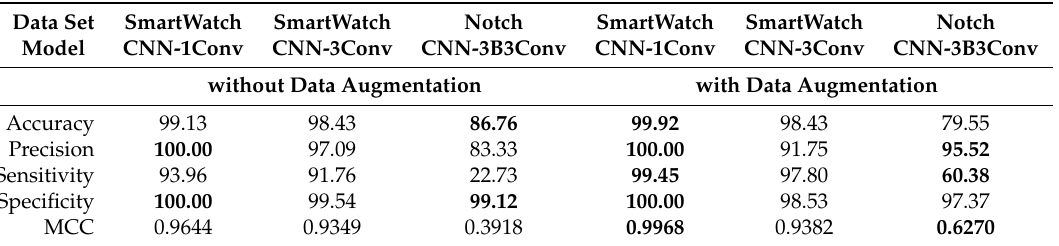
Table 2. Fall detection results (in %) when using the SmartWatch and Notch data